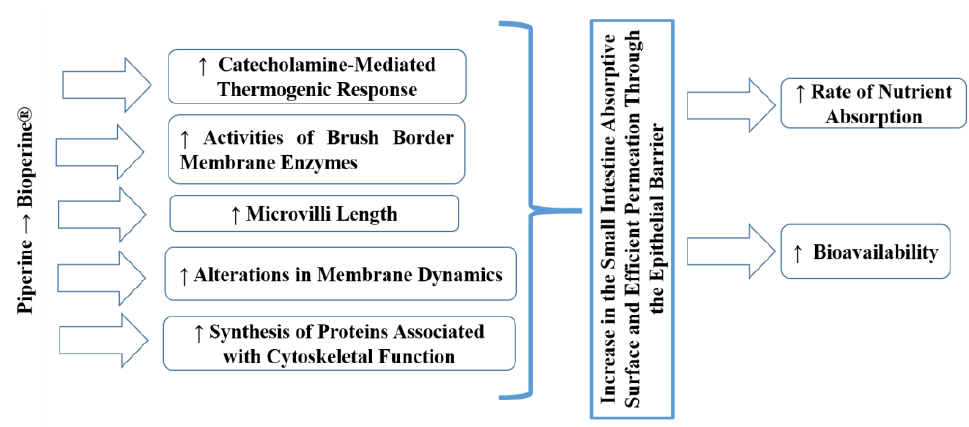
Figure 1. Action mechanism of piperine/Bioperine ® as a bioavailability enhancer.